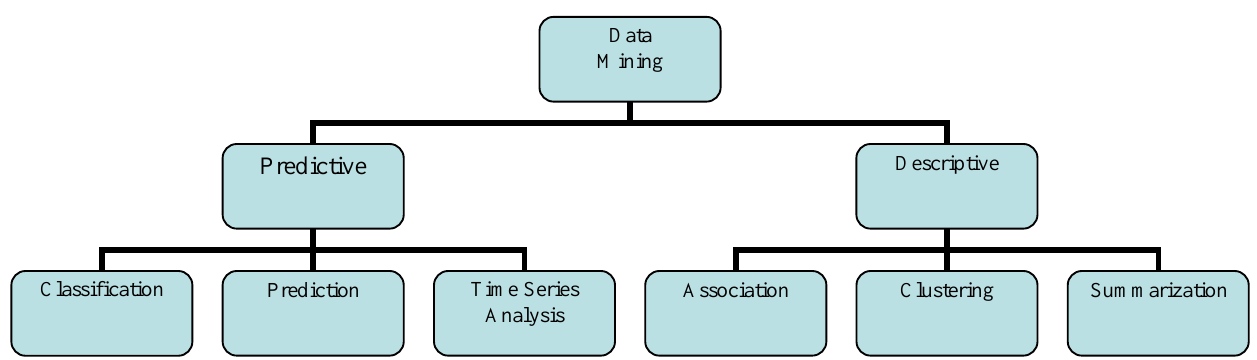
Figure 1. Different types of Data mining